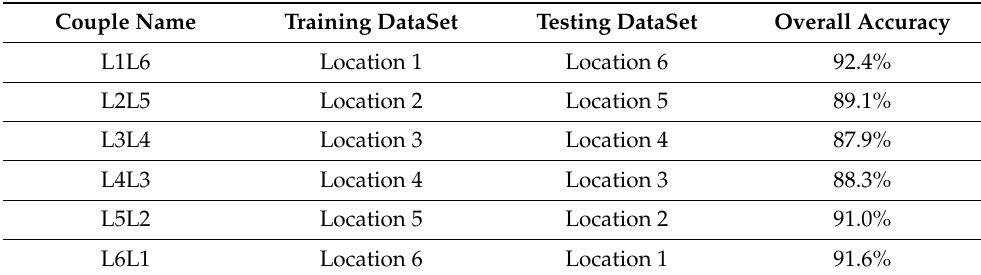
Table 2. Overall accuracies of